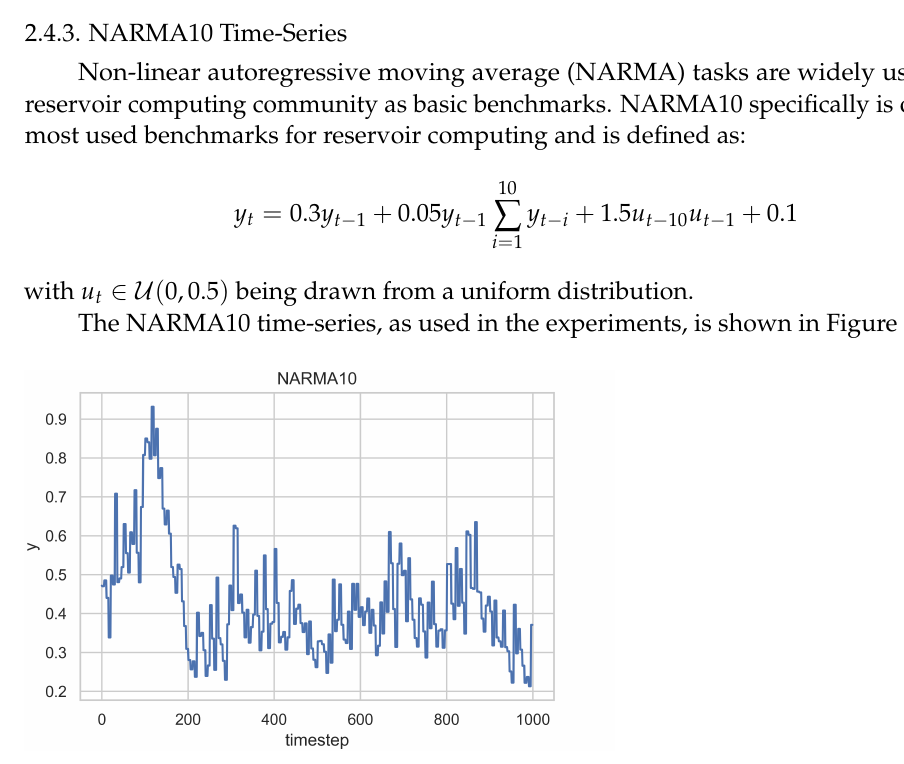
Figure 5. Hénon time-series as used in the experiments.